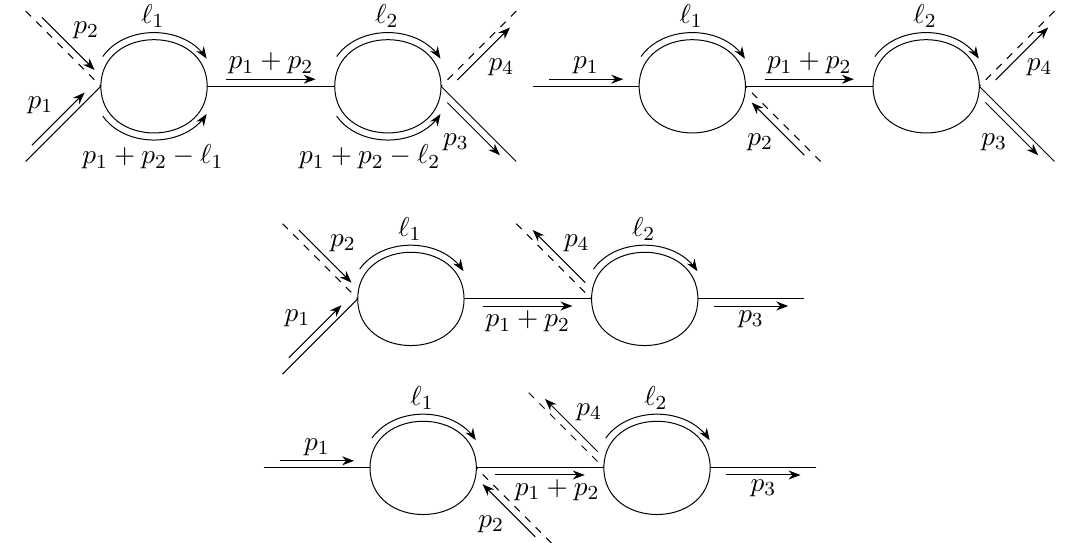
Figure 20 . Loop diagrams with s -channel pole for the scattering process AB → AB . The solid lines represent scalar particles (A) and dashed line represent dilatons (B). Using crossing symmetry p 2 ↔ − p 4 we can get the Feynman diagrams with u -channel